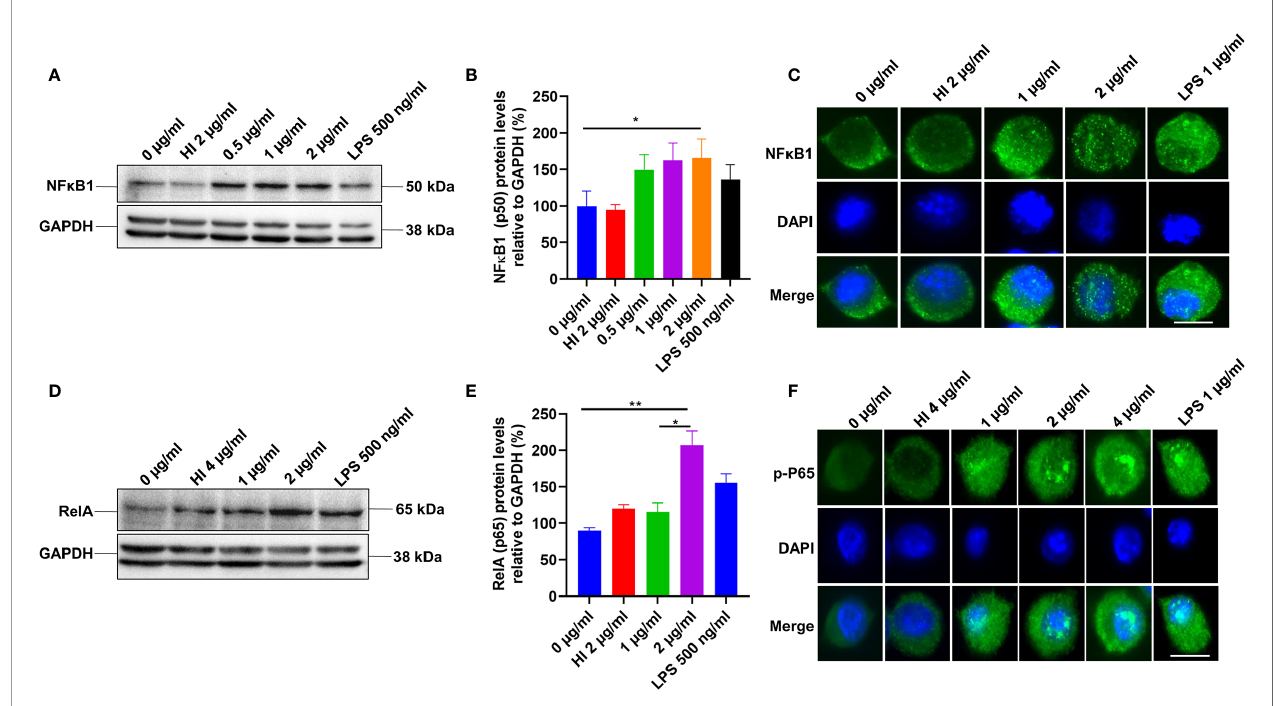
FIGURE 3 | PE6 induces the activation of the canonical NF k B signaling pathway. (A) Western blots showing the expression level of NF k B1 (P50) subunit of NF k B in PE6 treated RAW264.7 macrophage cells. RAW264.7 cells were treated with PE6 (1 and 2 µg/ml) for 24 h. (B) Densitometric quantitation of the P50 subunit of canonical NF k B. P50 protein levels were expressed relative to GAPDH [%]. (C) Immuno fl uorescence microscopic pictures showing nuclear translocation of P50 subunit. (D) Western blots showing the protein levels of the phosphorylated pP65 (RelA) subunit of NF k B in PE6 treated RAW264.7 macrophage cells. (E) Densitometric quantitation of pP65 subunit. The pP65 protein levels were expressed relative to GAPDH [%]. (F) Immuno fl uorescence microscopic pictures showing nuclear localization of phosphorylated P65. DAPI was used to mark the nucleus. Untreated and HI PE6 treated cells were used as negative controls. LPS (500 ng and 1 µg/ml) treatment was used as a positive control. GAPDH was used as a loading control. A488 linked secondary antibody was used for signal detection. Scale bars indicate 10 µm. Data were analyzed by one-way ANOVA with Tukey ’ s multiple comparison post-test. Data are representative of three independent experiments. *P < 0.05 and **P < 0.01 vs .